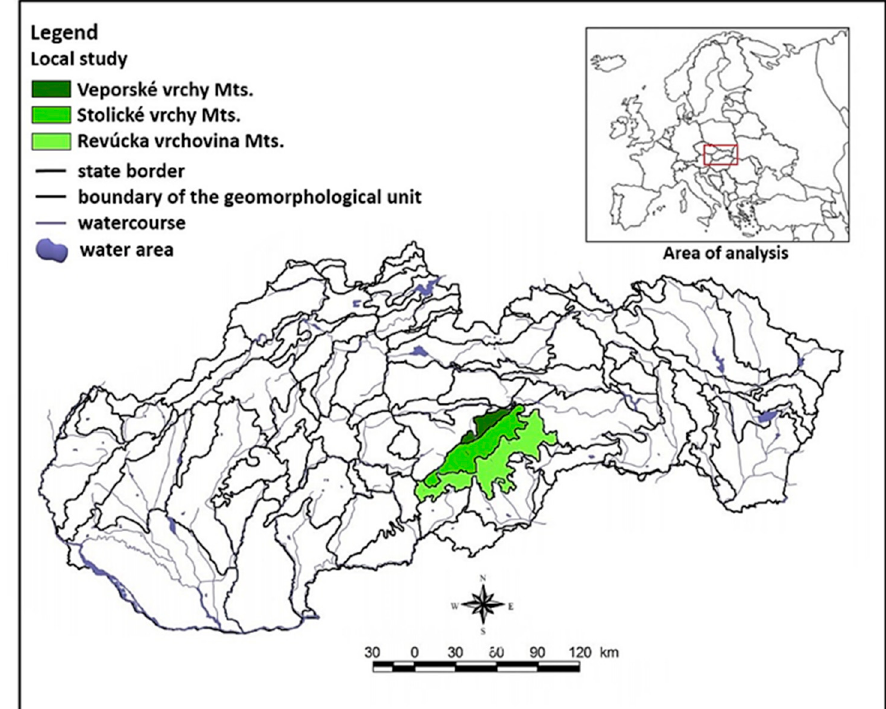
Figure 1. Map of the studied area.